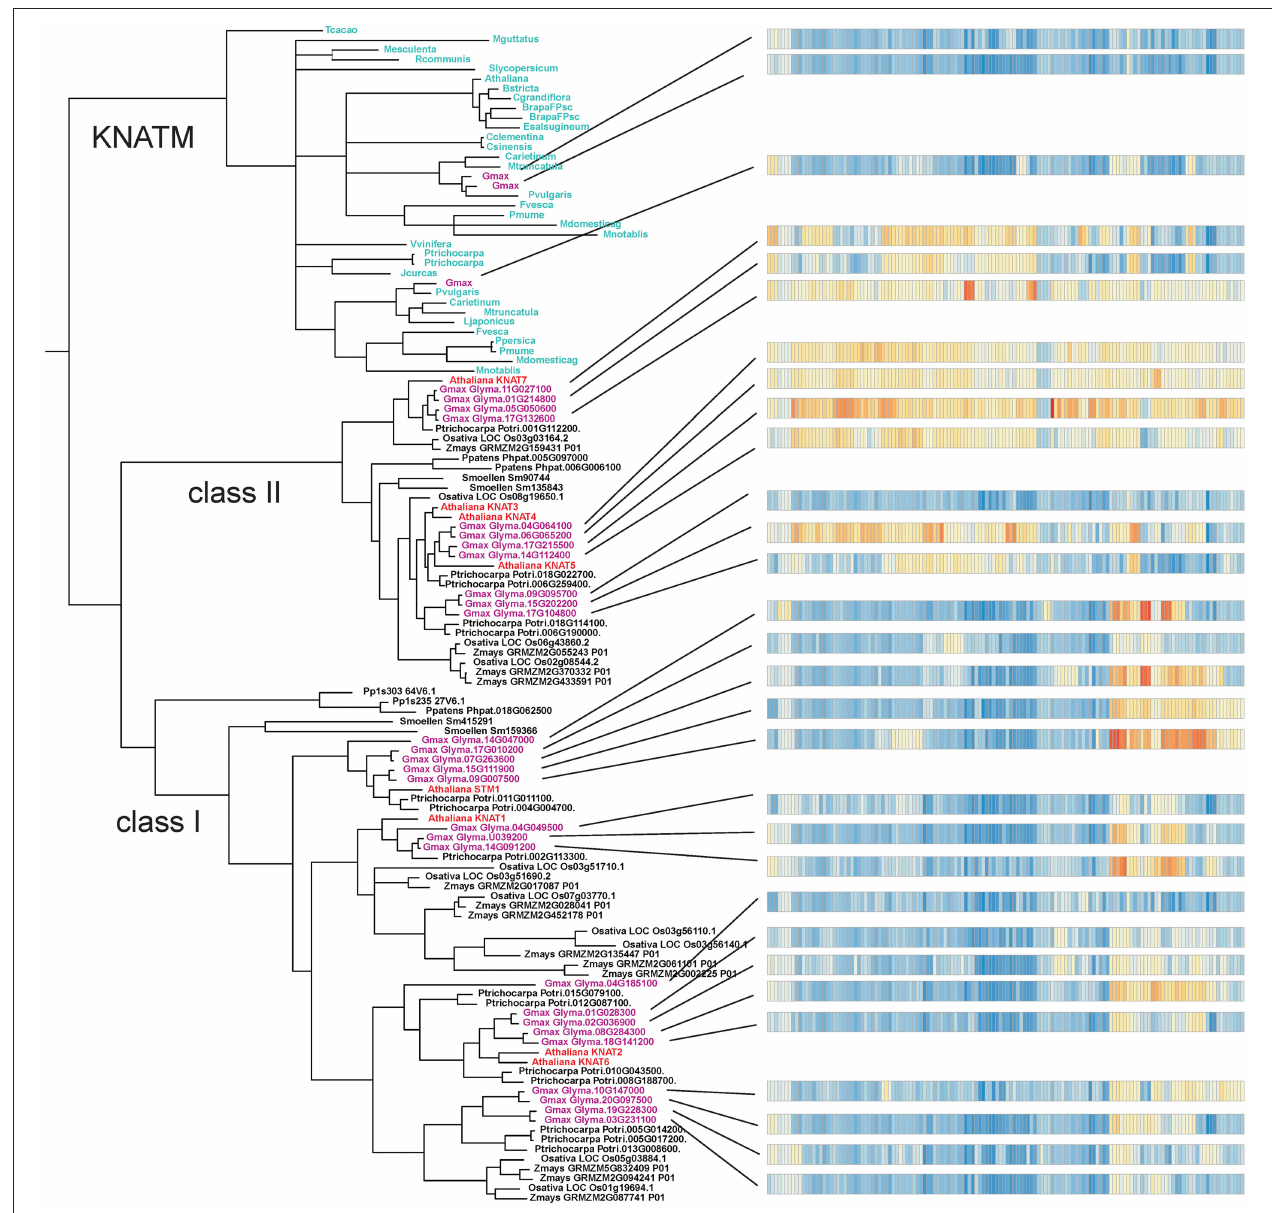
FIGURE 6 | Diversification and expression of Glycine max KNOX proteins. Each horizontal bar on the right represent a set of 138 different RNA-Seq samples from the Harada-Goldberg soybean seed LCM dataset. RNA-Seq analyses are described under “Materials and Methods” and more details on this figure may be found in the Supplementary Tables 1 , 2 , Supplementary Data Sheet 1